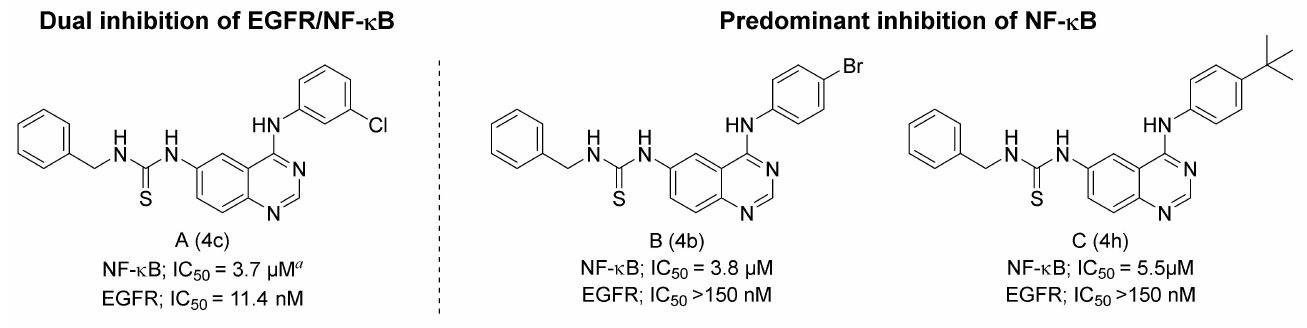
Figure 2. Thiourea quinazoline derivatives from our previous series [35]. a NF- κ B inhibition values were derived from a cell-based activity reporter assay, whereas the IC 50 s for EGFR kinase inhibition were obtained in a cell-free kinase assay (at 100 µ M ATP). The codes in brackets denote the old compound names from Ref.